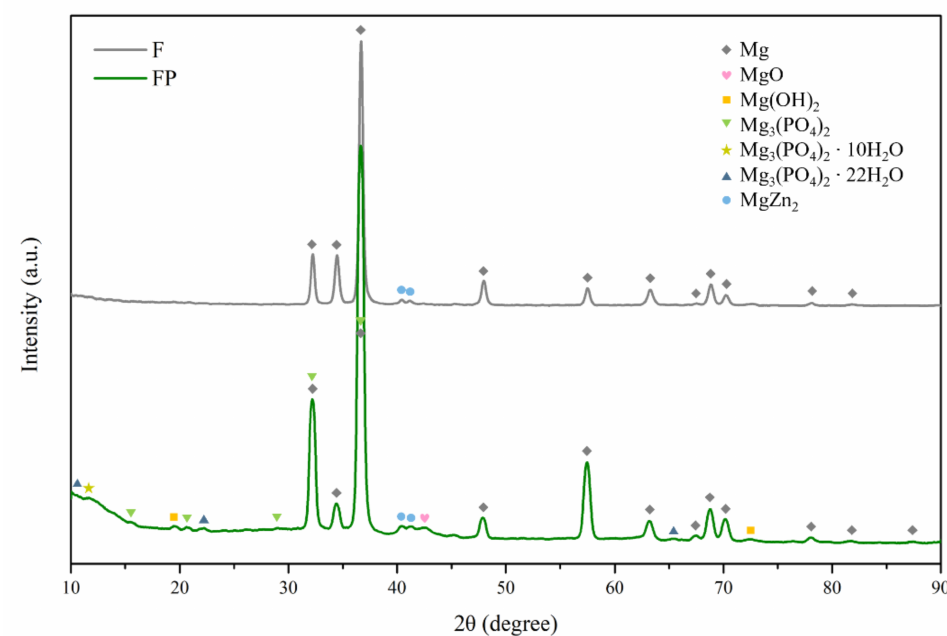
Figure 4. XRD patterns of F and FP.